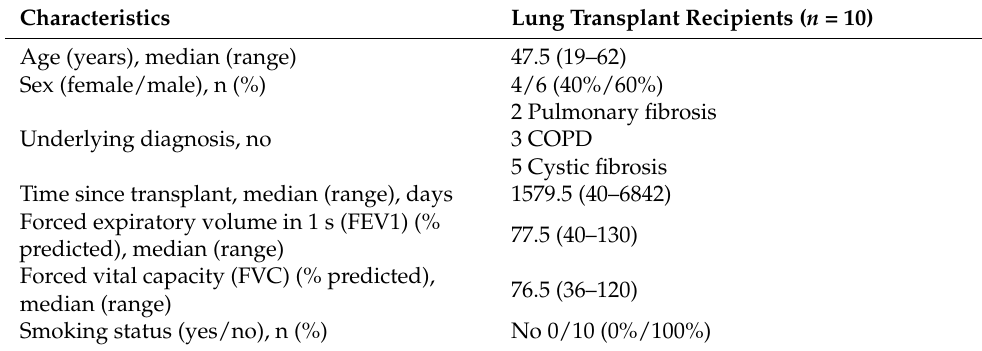
Table 2. Patient baseline characteristics.